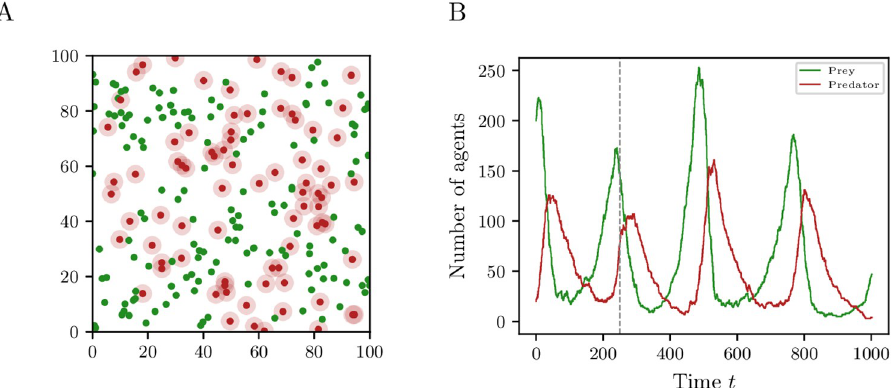
Fig 3. Simulation of predator-prey model. (A) Snapshot of the state of the predator-prey ABM at time t = 250. Red and green dots represent predators and prey, respectively. The radius of vision is indicated by the light-red area around the predators. (B) Simulation of the predator-prey model for the parameters given in Table 2 on page 17. The vertical gray dashed line indicates the time where the snapshot in (A) is taken.